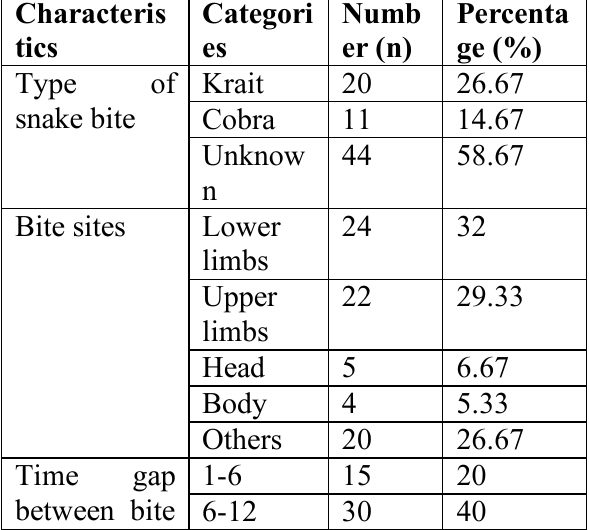
Table 2: Distribution of patients according to type of snake bite, bite site, time to reach hospital after bite